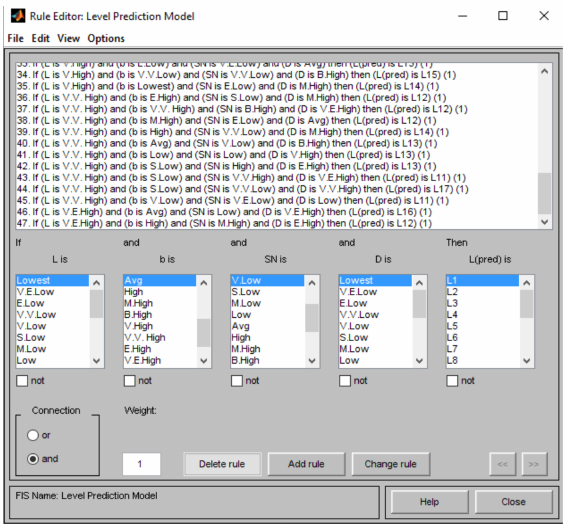
Figure 10. The rule editor in the MATLAB platform.